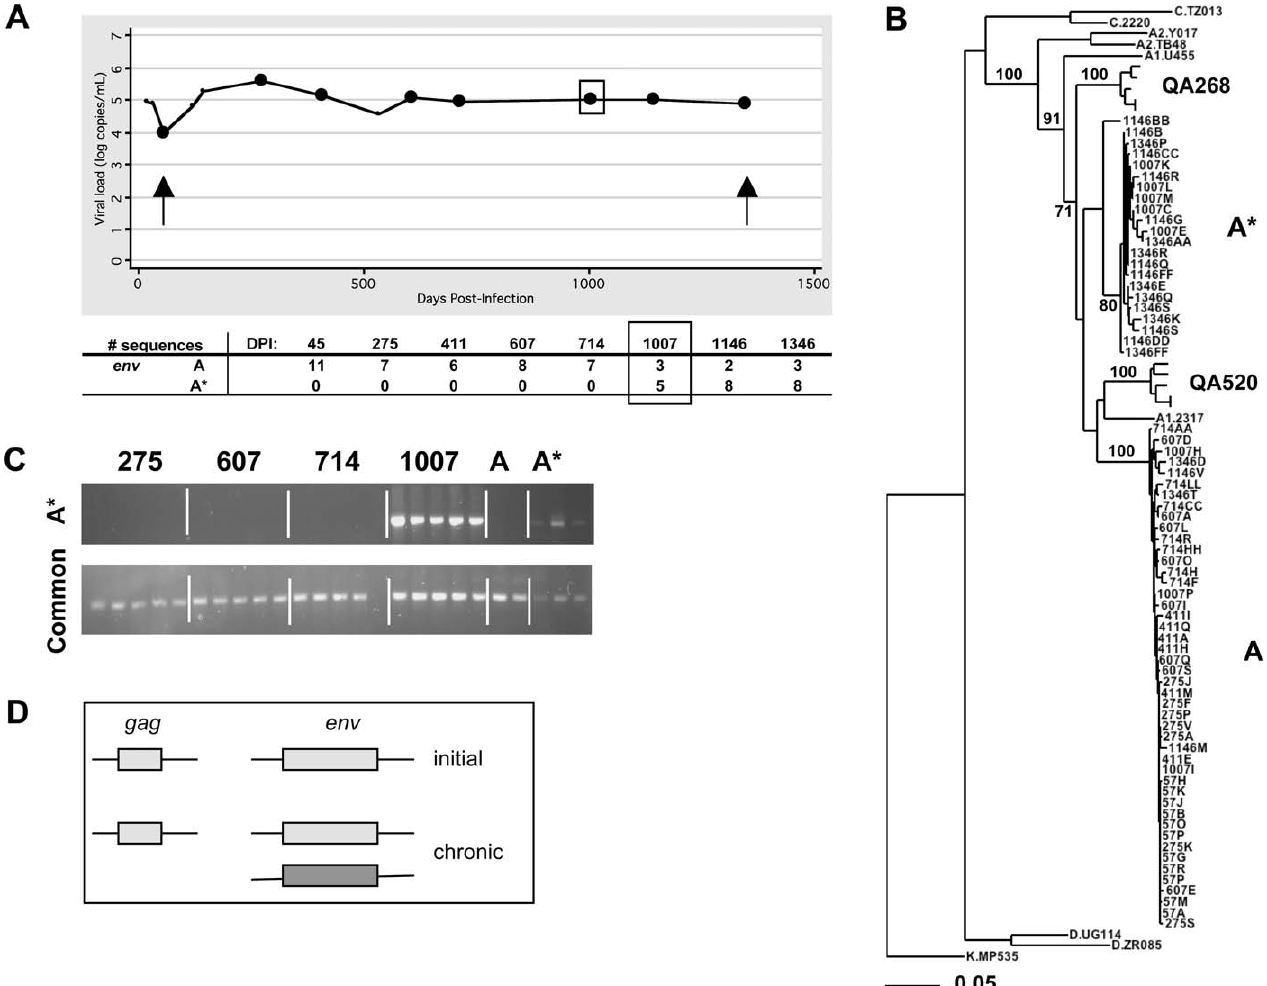
Figure 7. Case 5 (QA413): Intrasubtype Superinfection (Subtype A) between 714 and 1,007 DPI Detected in env (B) Maximum-likelihood tree of env sequences from all time points. The cluster of strain A contains sequences from all time points, while the cluster of strain A* contains sequences from 1,007, 1,146, and 1,346 DPI. (C) Amplification of 50 env HIV-1 genome copies from the indicated time points using strain-specific primers (top panel) and common primers (bottom panel). (D) Summary of the strains detected. Light gray ¼ subtype A; dark gray ¼ A*.